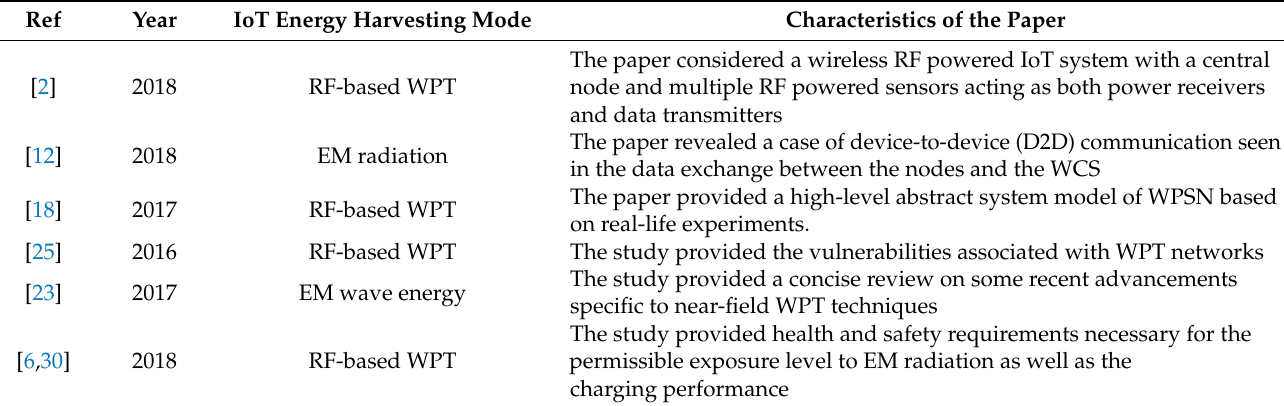
Table 2. Different modes of IoT energy harvesting for WPT technology.